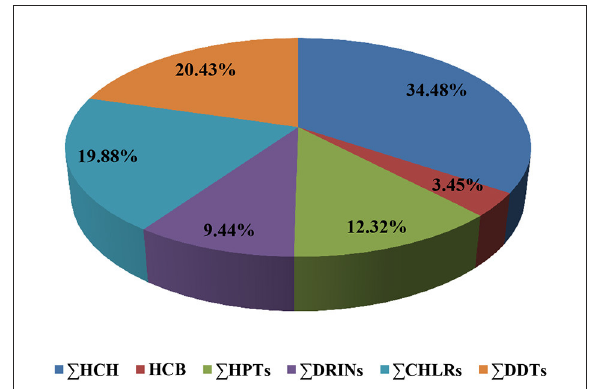
FIGURE1 Distribution percentages of organochlorine pesticide groups in all examined seafood.